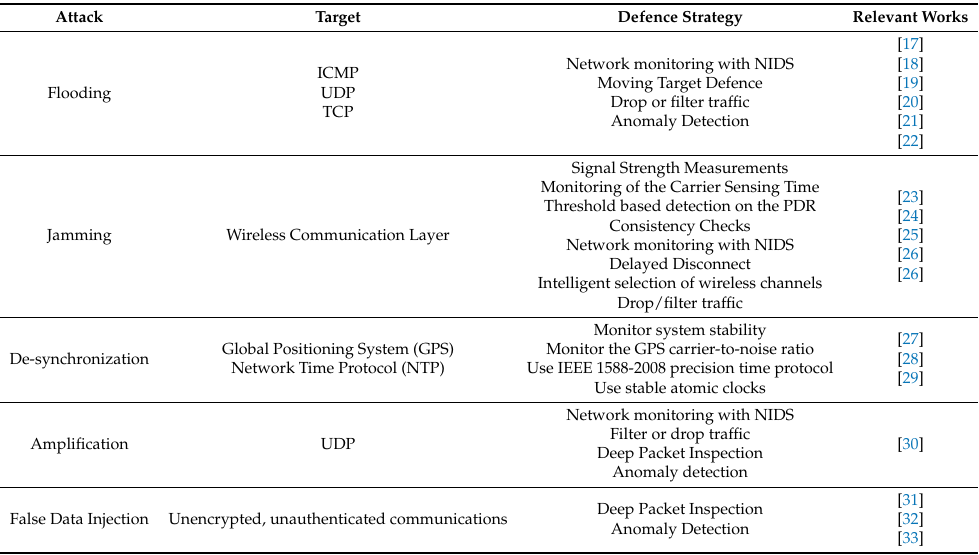
Table 1. Summary of the main DoS attacks against the smart grid, relevant works and main identified defence